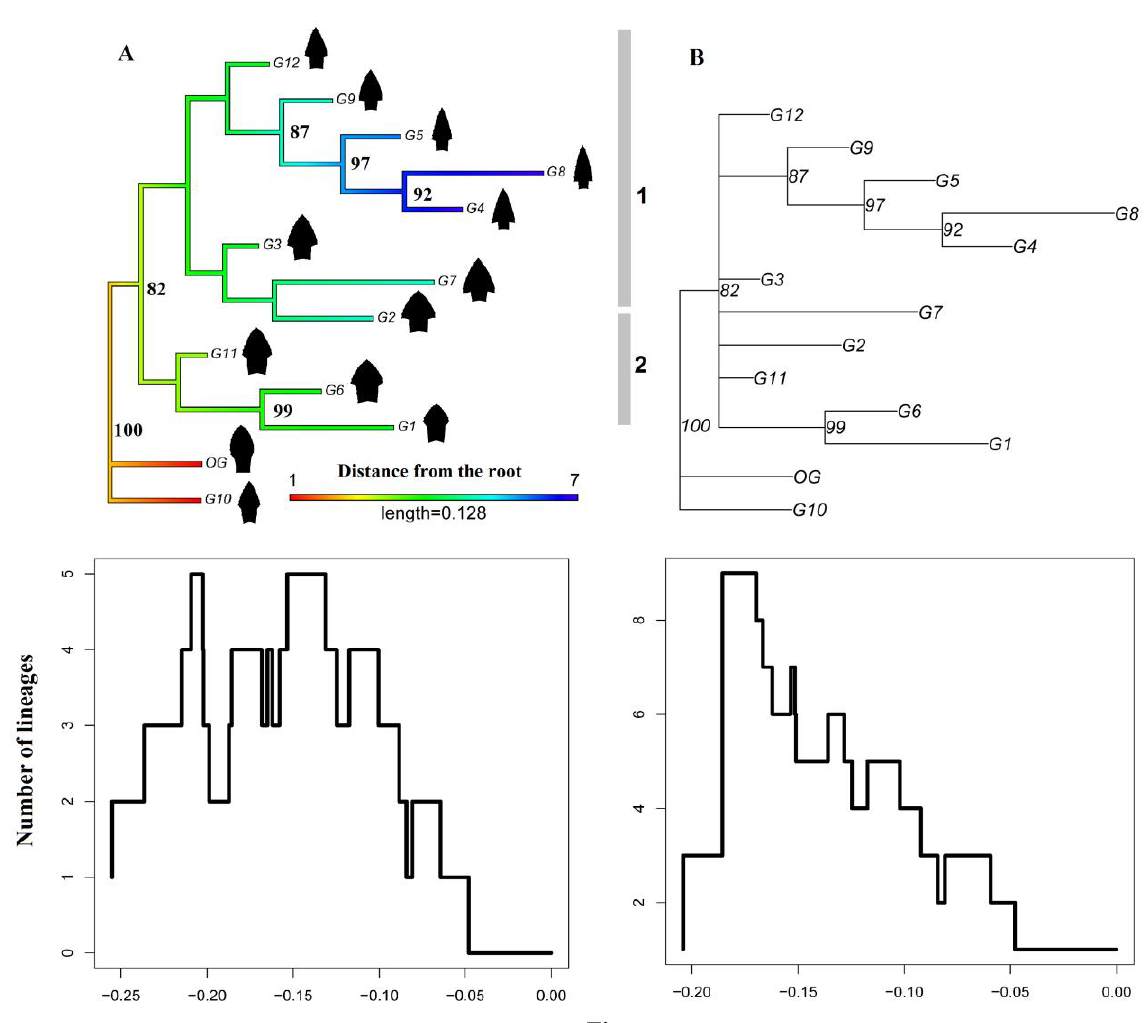
Figure 4. Resolved (A) and consensus (B) tree. Resolved tree also shows a distance scale from root to tips. At the bottom: corresponding lineages through time plots to each tree. In resolved tree A, the main clades with high support measure (82%) are shown (grey bars 1 and